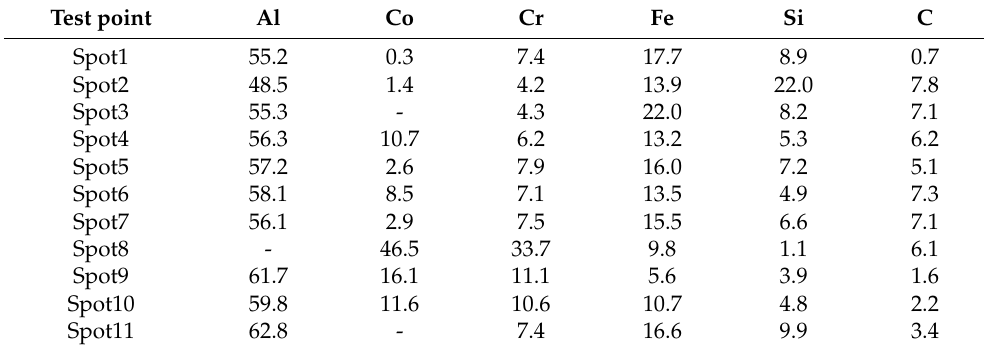
Table 3. Elemental composition of different zones after aluminum corrosion (wt%).